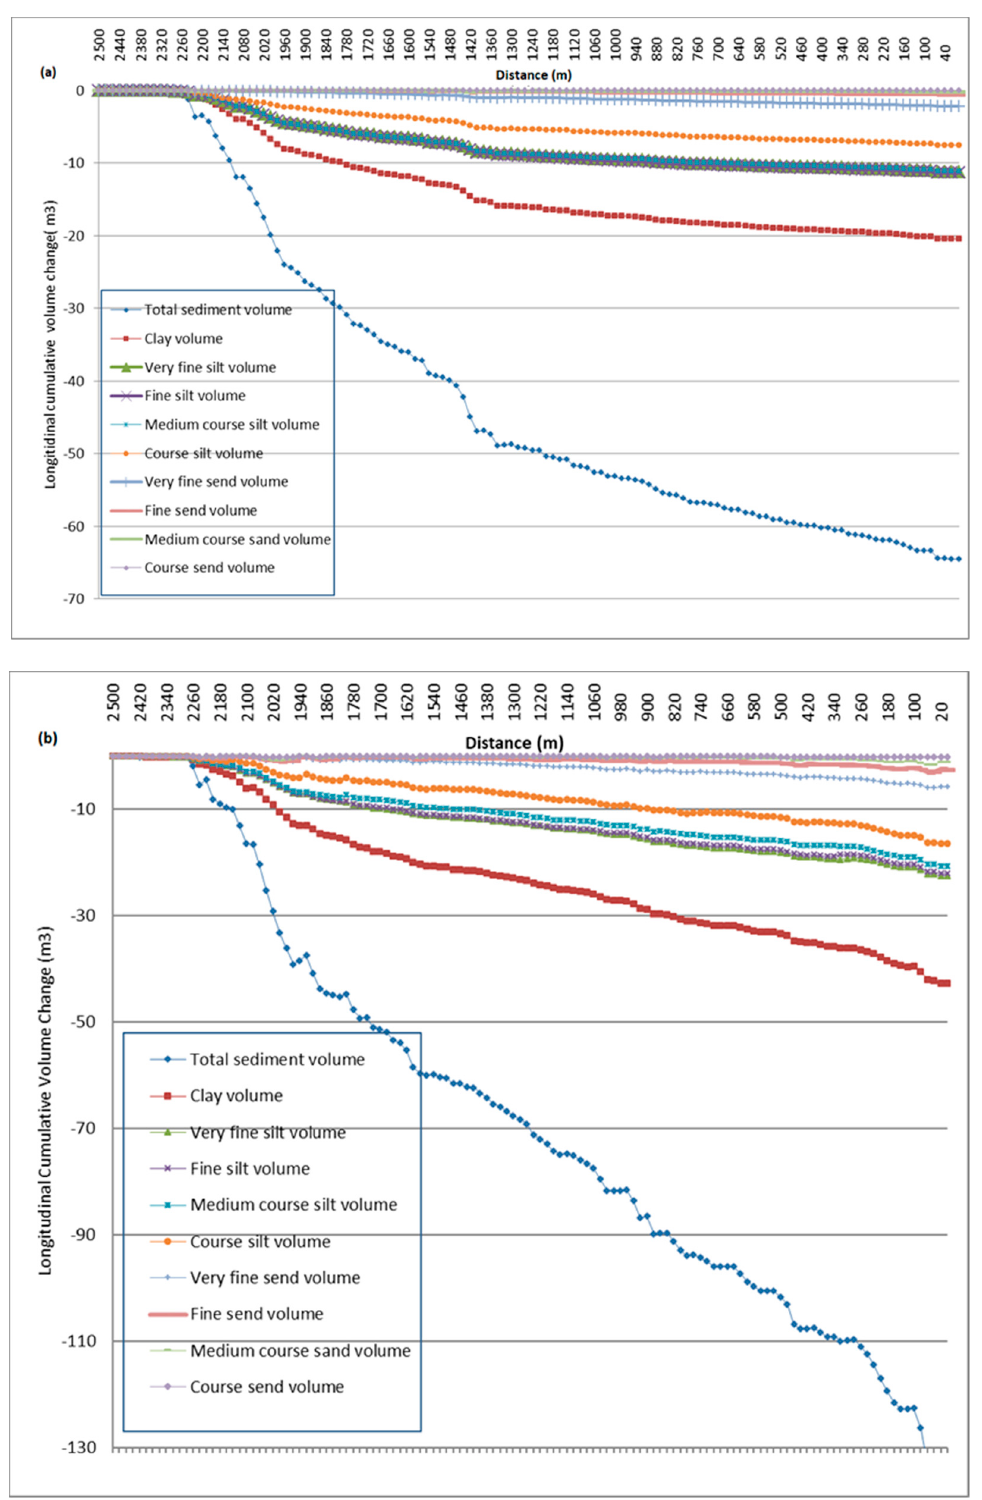
Figure 8. Longitudinal change in sediment volume in the period 13 May and 20 May 2014 ( a ) and longitudinal change scheme of the 50-year return period ( b ).